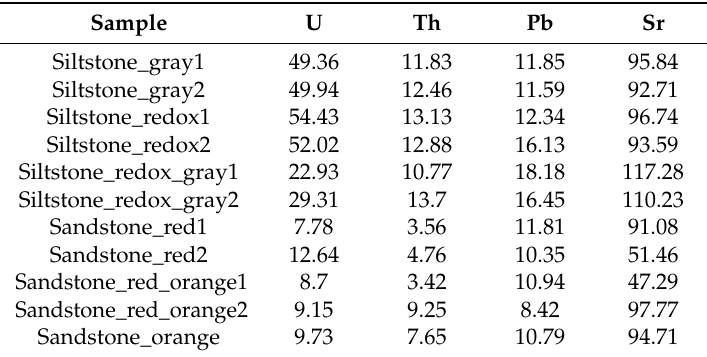
Table 8. Assays related to “Multicolored Series” sediments (values are in